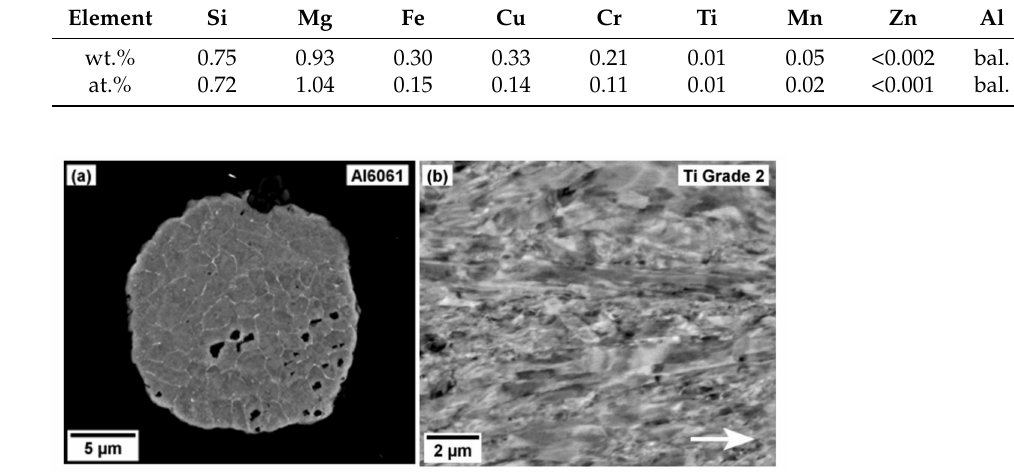
Figure 1. Cross-sections of ( a ) Al6061 powder particle, ( b ) Ti Grade 2 wire with an extrusion direction marked by the